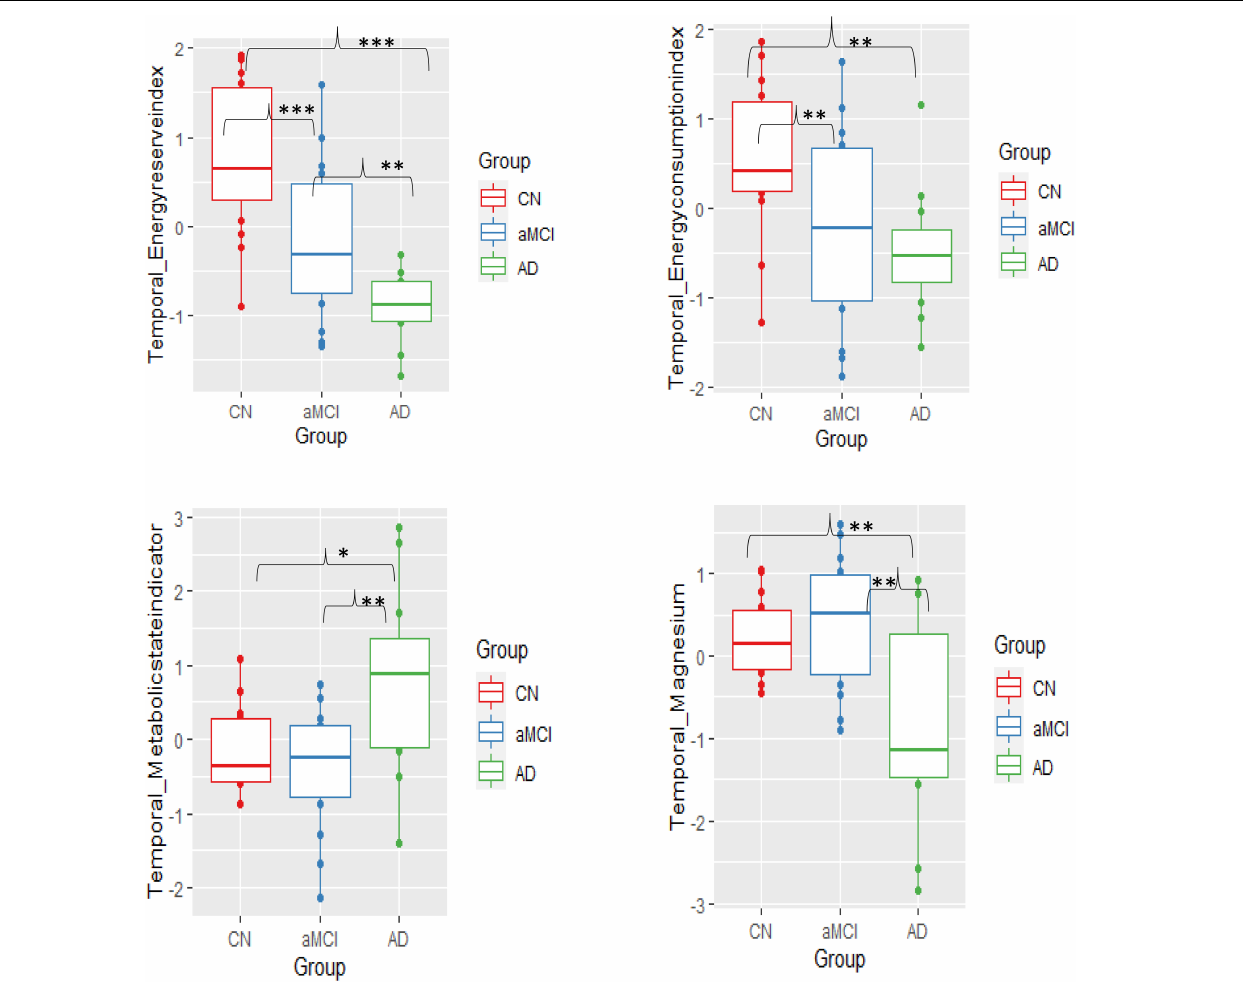
FIGURE 3 | Group mean differences of BEM markers – energy reserve index, energy consumption index, metabolic state, and intracellular pH in the temporal lobe across the three groups-cognitively normal (CN), amnestic mild cognitive impairment (aMCI), and mild Alzheimer’s disease (AD) (significant differences p = 0 . 10*, p = 0 . 01**, p ≤ 0 .